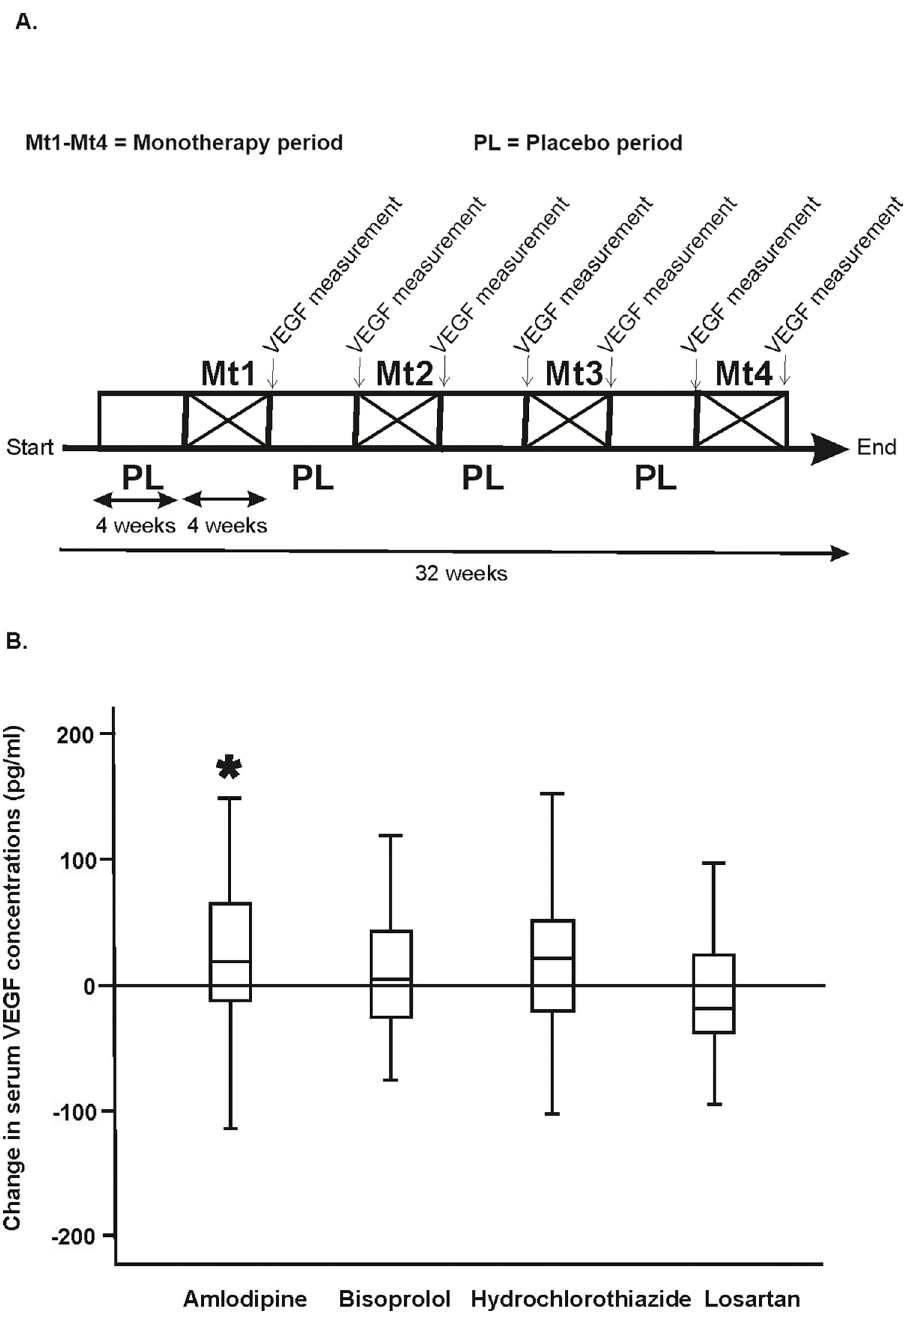
Fig 2. A: Schematic diagram showing the interventional clinical study design and the sample collection timeline. B: Median and interquartile range changes in the serum VEGF concentration after 4 weeks of daily monotherapies with amlodipine (5 mg), bisoprolol (5 mg), hydrochlorothiazide (25 mg) or losartan (50 mg) compared to the wash-out phases. The nonparametric Wilcoxon signed ranks test was used to test the statistical significance of the drug-induced changes in serum VEGF. * P-value < 0.05 denotes statistical